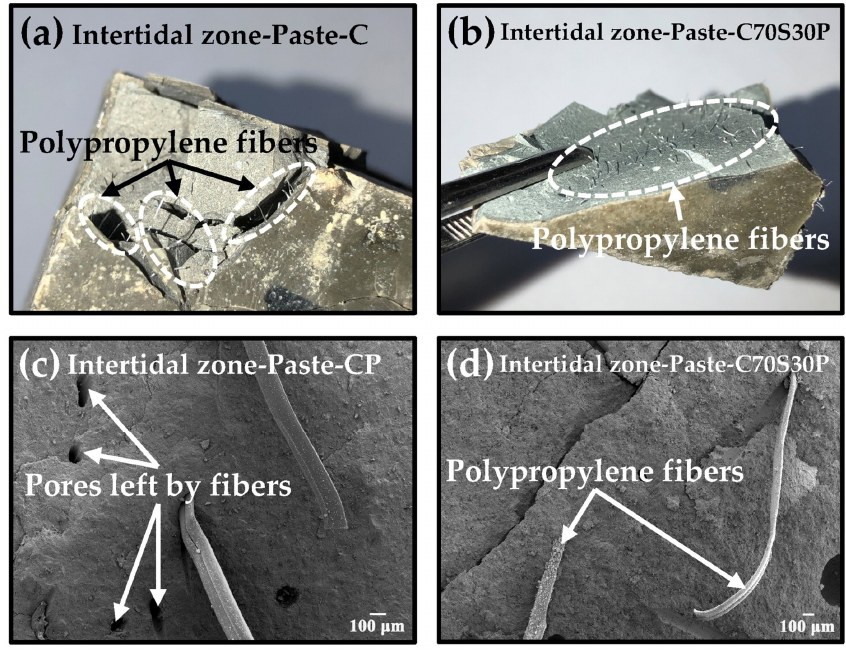
Figure 13. The influence of polypropylene fibers on the internal microstructure of CBRM-Paste after 180 days of dry–wet cycles-coupled chloride ion erosion.